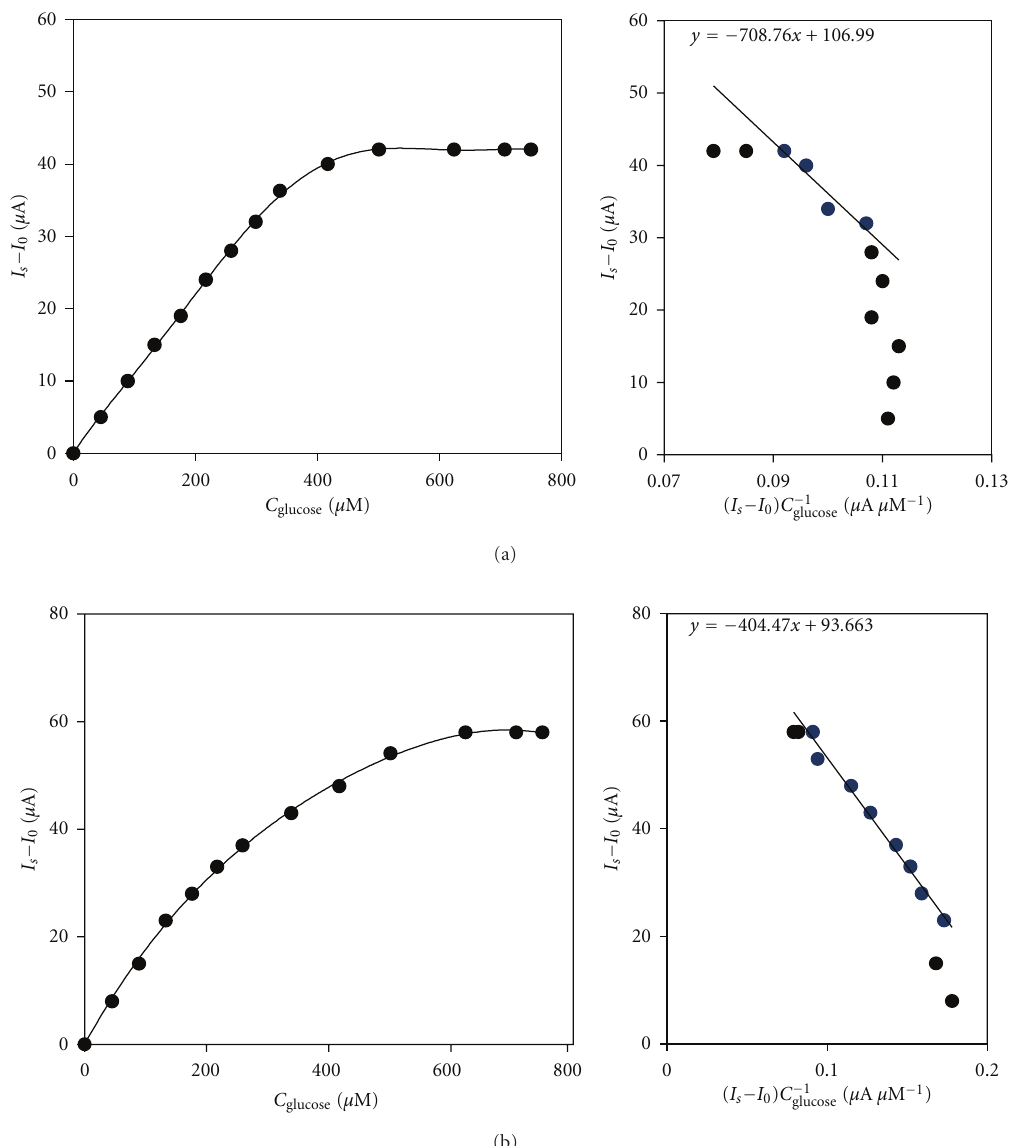
Figure 4: Calibration graphs (left sides) and Eadie-Hofstee plots (background subtracted steady-state current as a function of electrode sensitivity, right sides) registered at an applied potential of − 50 mV (Ag/AgCl, 1MKCl); phosphate-citrate bu ff er, pH 7.0; temperatures: (a) 25 ◦ C, (b) 30 ◦